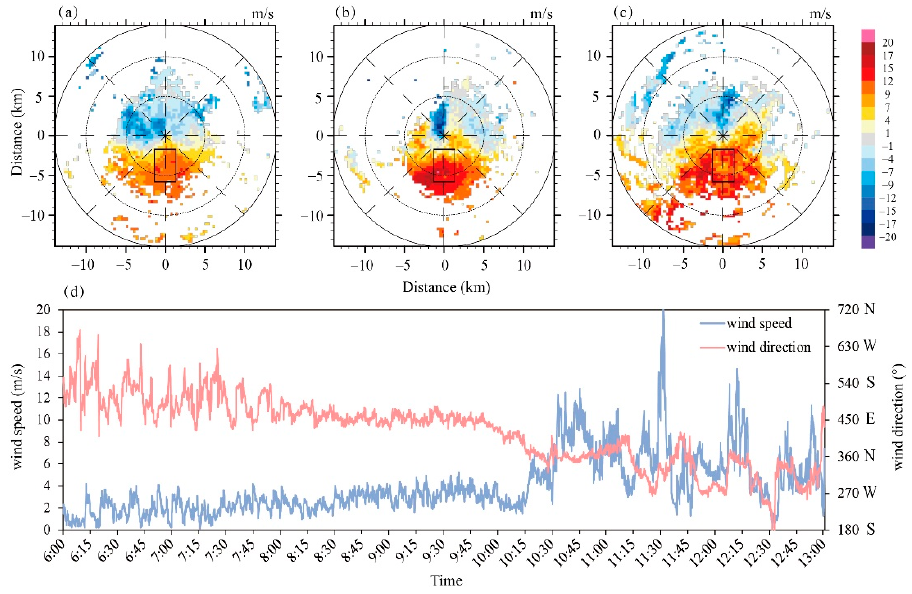
Figure 2. Lidar plan position indicator (PPI) scan for Vrs at a six-degree elevation at ( a ) 11:18 UTC, ( b ) 11:27 UTC, and ( c ) 11:36 UTC, respectively, and ( d ) time series of the 10 m wind speed (blue) and wind direction (red) observed by an automated weather observing system (AWOS).